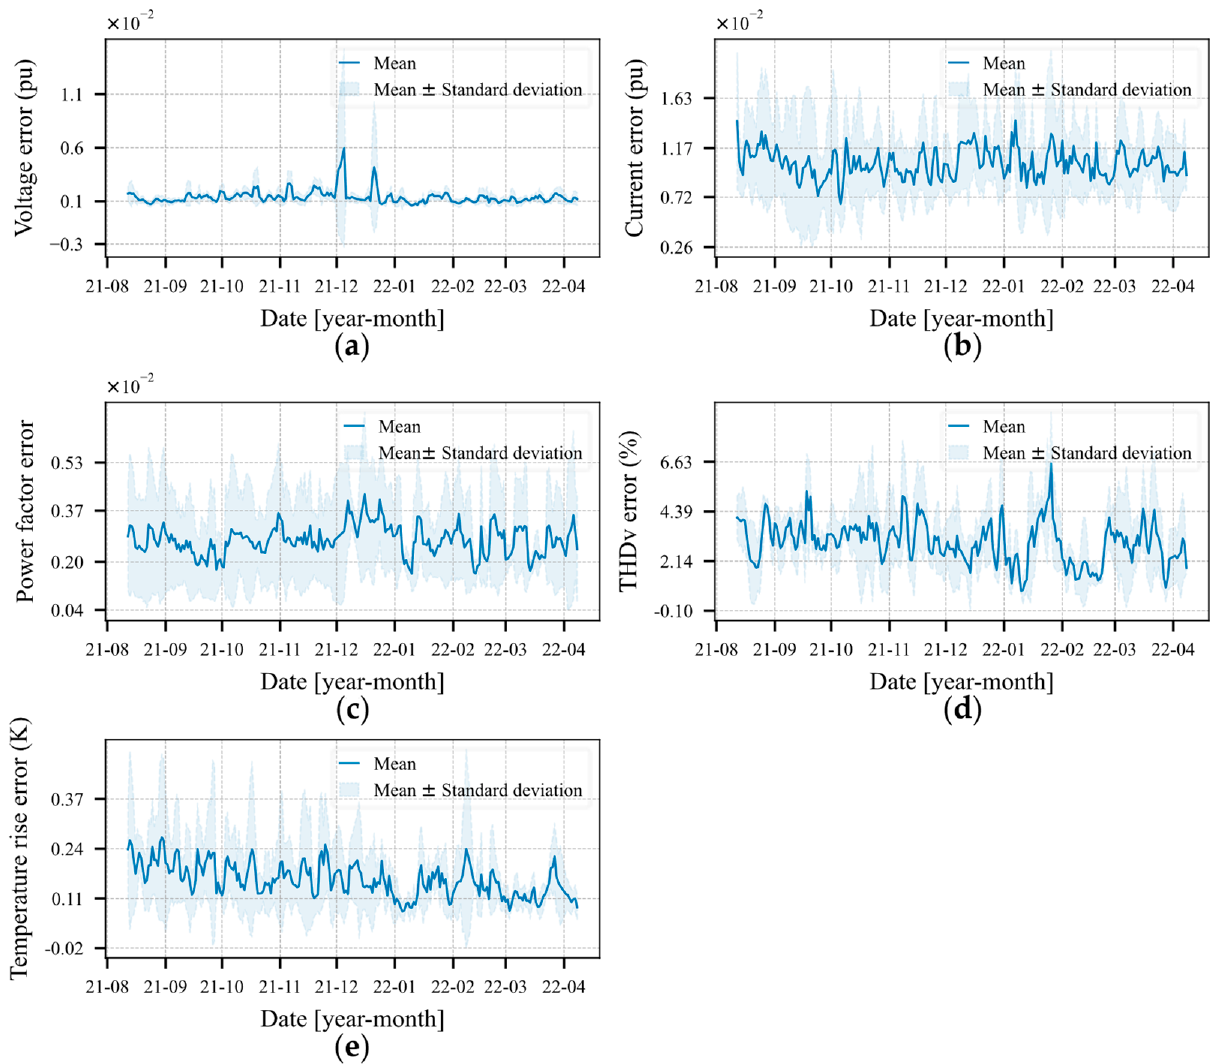
Figure 10. Mean individual reconstruction error of the five transformers. ( a ) Sum of the errors over the three voltage phases. ( b ) Sum of the errors of the three phases over the currents. ( c ) Power factor ( d ) THDv. ( e ) Increase in tank temperature.